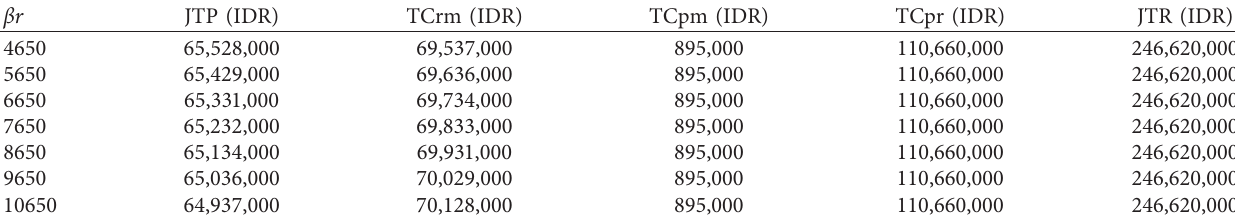
Table 13: Sensitivity analysis of the effect of β r on cost, revenue, and profit.